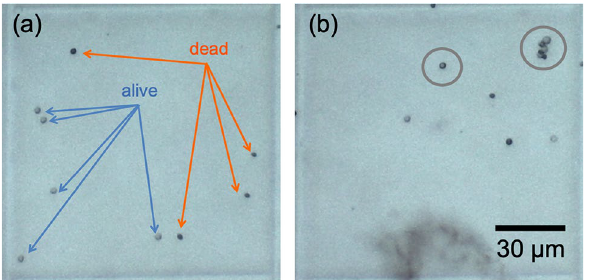
Figure 4. Typical results of a trypan blue exclusion assay. ( a ) A grid cell showing a mix of live and dead yeast cells. Live cells do not absorb the dye and appear light gray. They are identified with blue arrows. Dead cells are permeable to the dye and appear dark blue/gray. They are identified with orange arrows ( b ) A grid cell showing cells with an inconclusive viability status based on the trypan blue exclusion assay. Those with an inconclusive status are circumscribed by gray